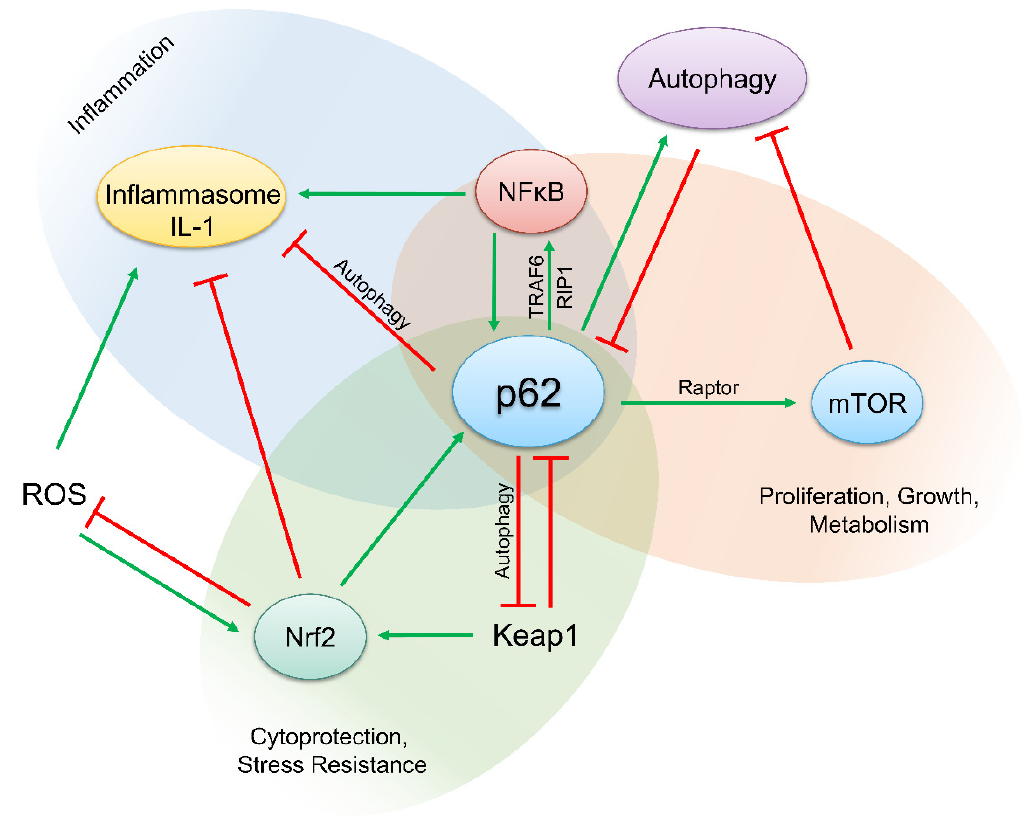
Figure 4. p62 regulates and links central pathways in inflammation and cancer development. p62 is an important cargo receptor for autophagy and mitophagy and thus inhibits inflammasome activation and inflammation. Moreover, upon Keap1 binding, p62 activates Nrf2 and attenuates inflammation. In contrast, p62 activates NF- κ B, a central regulator of inflammation and cancer development, and the kinase mTOR that induces anabolic pathways.